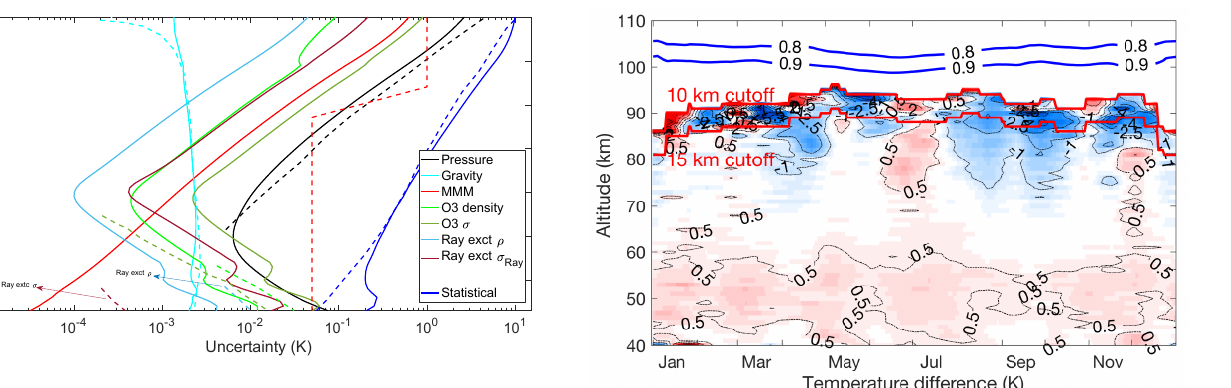
Figure 9. Comparison of the PCL statistical and systematic uncer- tainties with scaled uncertainties from Leblanc et al. (2016b) as de- scribed in the text. The solid lines are the uncertainties due to the PCL and the dashed lines are uncertainties due to NDACC2016. Figure 10. PCL temperature climatology difference between the